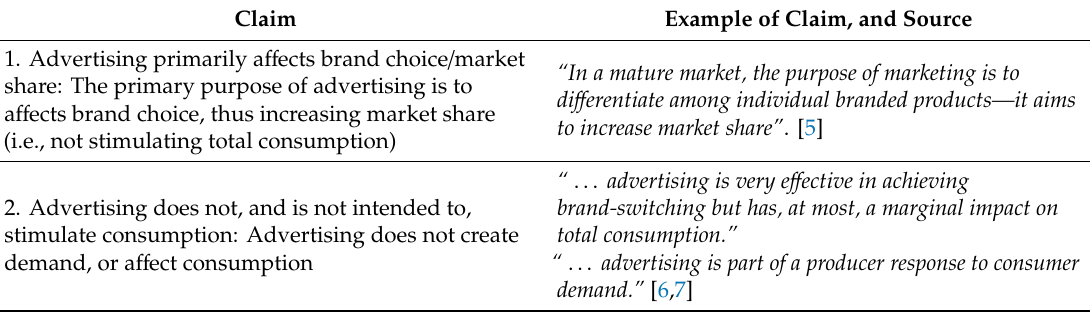
Table 1. Five common alcohol industry claims about the e ff ects of advertising on